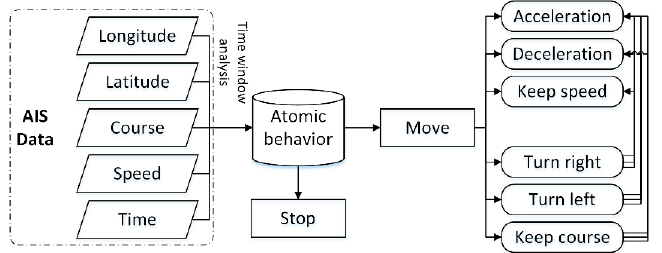
Figure 1. Classification of ship atomic behaviors adapted with permission from Ref. [2].